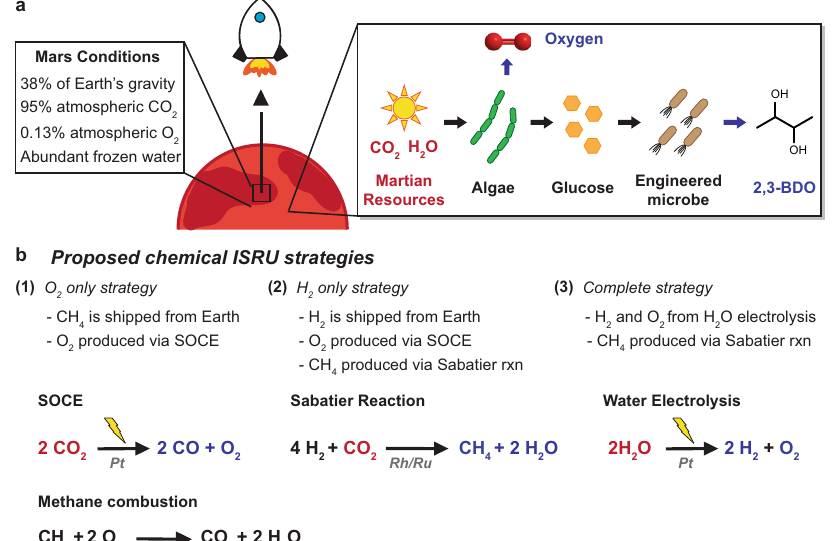
Fig. 1 Rocket propellant production on Mars via in situ resource utilization (ISRU). a Proposed biotechnology-enabled ISRU (bio-ISRU) takes into account Martian conditions to produce a Mars-speci fi c propellant, 2,3-butanediol (2,3-BDO). Using sunlight, carbon dioxide (CO 2 ), and water, cyanobacteria (algae) are grown as a feedstock for an engineered microbe that produces 2,3-BDO. Cyanobacteria cultivation evolves oxygen for spacecraft launches or other aspects of Martian exploration. b Proposed chemical ISRU strategies focus on the use of methane (CH 4 ) as a propellant. The most examined chemical processes that can be part of a chemical ISRU strategy 2 . (1) O 2 only strategy. SOCE: solid oxide CO 2 electrolysis. (2) H 2 only strategy. (3) Complete strategy. Key chemical reactions: SOCE, Sabatier reaction, and water electrolysis. Martian resources in red. Chemicals produced on Mars in blue. Chemical shipped from Earth in black. Details on proposed biological and chemical ISRU strategies can be found in Table